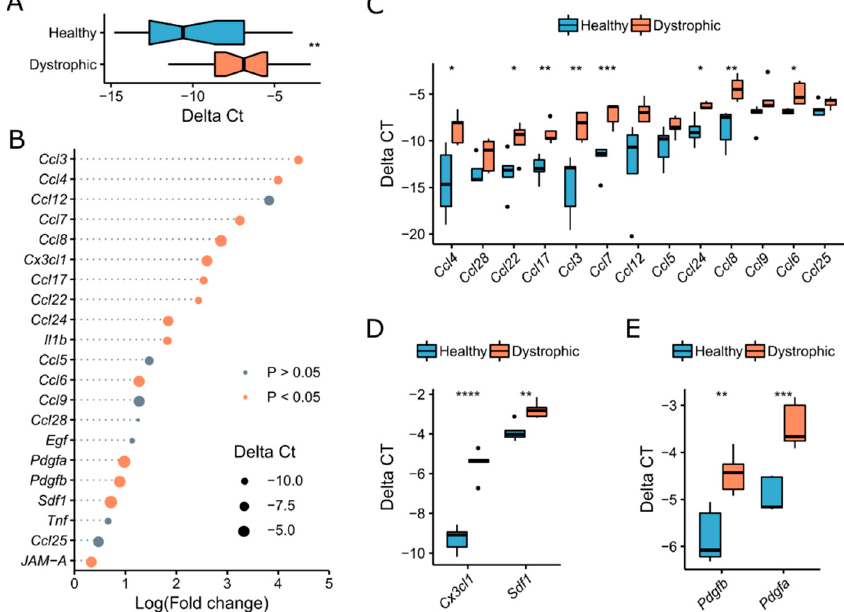
Figure 1. A general increase of chemokine expression in dystrophic skeletal muscle. ( A ) Boxplot of the average expression from 21 genes between the skeletal muscle of C57Bl6 (Healthy) and Sgca -null (Dystrophic) mice. n = 21, Wilcoxon rank-sum test. ( B ) Bubble chart displaying log fold increase of chemokine expression of Dystrophic compared to Healthy skeletal muscle. n = 5. ( C – E ): Expression of CC-chemokine family genes ( C ), CXC and CX3C family genes ( D ) and PDGF family genes ( E ) in dystrophic compared to healthy skeletal muscle from ( B ). Expression values as ∆ C t, normalized to housekeeping genes ( Rpl13a , Rab35 , Psma3 ). n = 5. * p ≤ 0.05, ** p ≤ 0.01, *** p ≤ 0.005, **** p ≤ 0.001, t - t test.